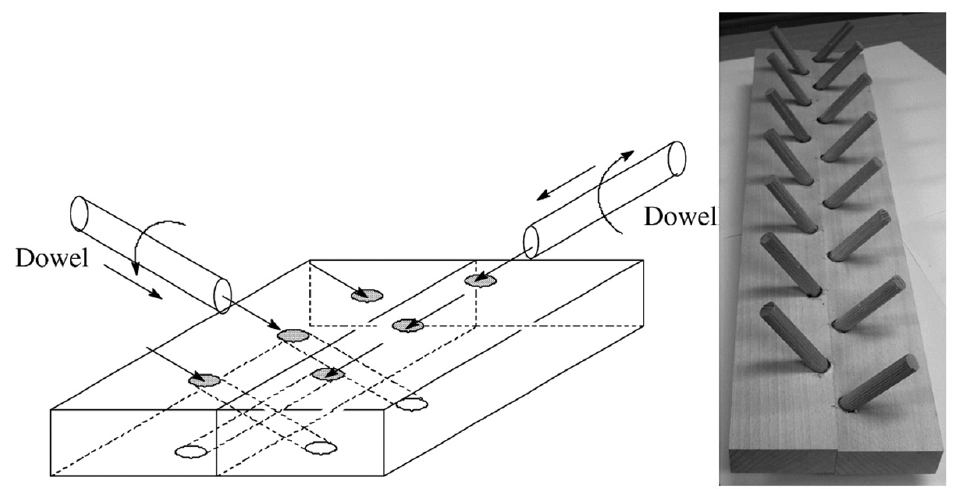
Figure 14. A joint of two pieces of wood edge-wise joined by rotary-welded wooden dowels in a zig-zag pattern [115].